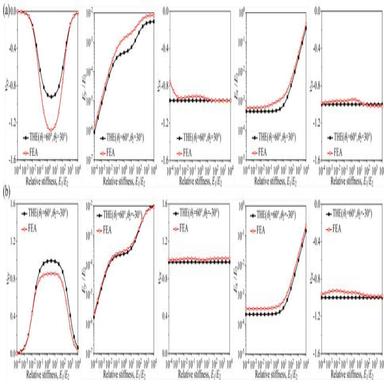
FEA verification of theoretical results of elastic constants of composite 3D DVH lattices, the equivalent Poisson's ratio and relative Young's modulus of (a) concave (θ1 = 60◦, θ2 = 30◦) and (b) convex (θ1 = 60◦, θ2 = − 30◦) 3D DVH lattices as functions of relative stiffness of the two constitute materials (t1/l = t2/l = b/l = 0.1).